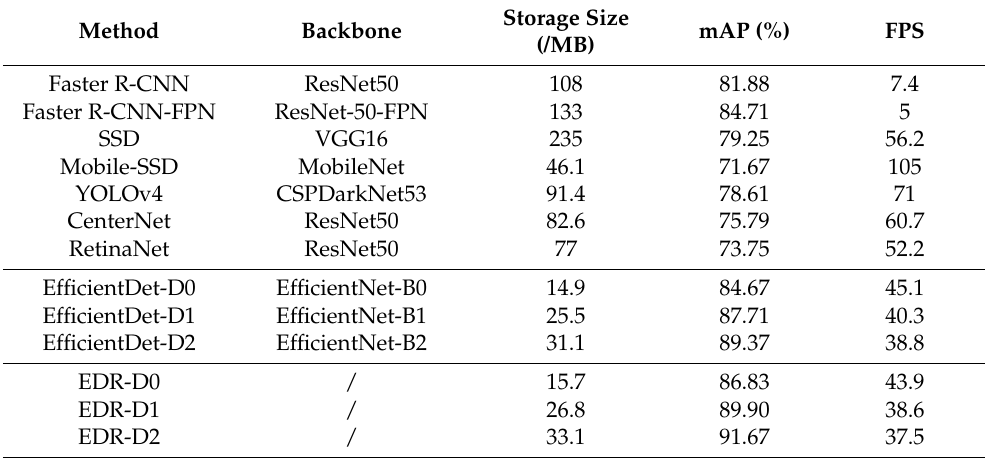
Table 3. The experimental results with different object detection